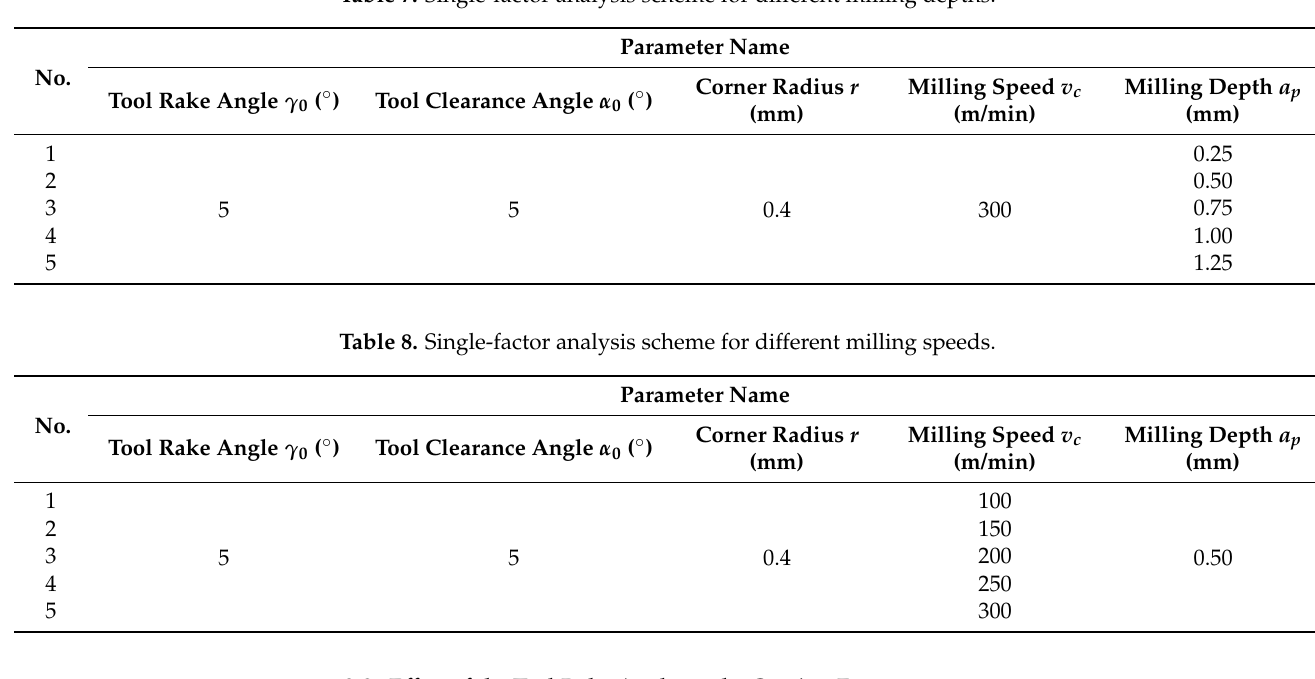
Table 7. Single-factor analysis scheme for different milling depths.